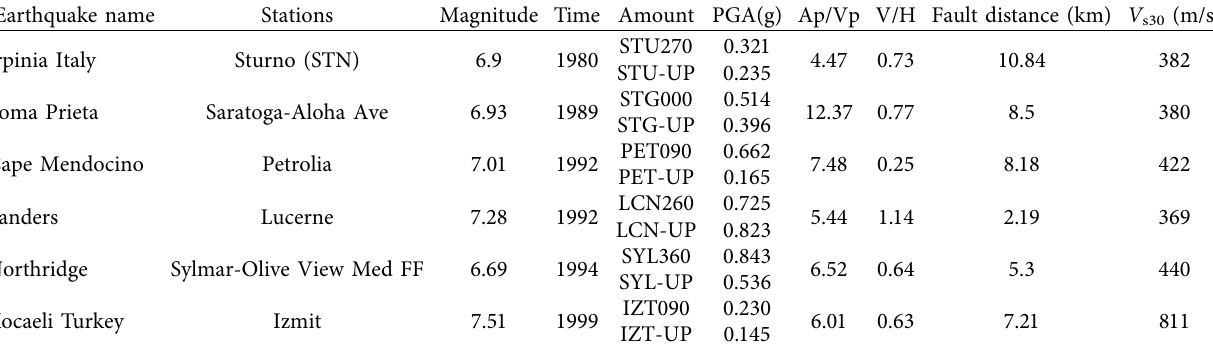
Figure 1: Time-history curves of ground motions: (a) Loma Prieta STG000; (b) Kocaeli_ Yarimca; (c) Hector Mine BRS090. Table 1: Impulse-type NF ground vibration information